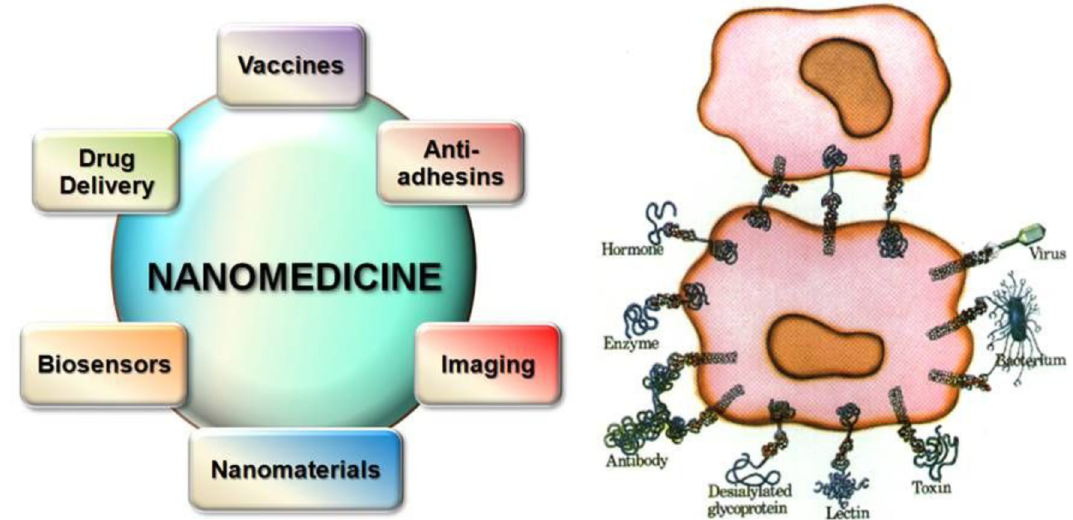
FIGURE 2- Left: Overview of applications involving glyconanoparticles. Right: Cell surface carbohydrates are involved in several pathogenicities including cancer and bacterial adhesions. Adapted from: http://www.glycotech.com (formerly BioCarb